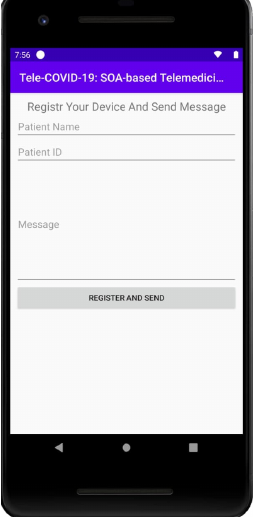
Figure 8. Tele-COVID patient registration